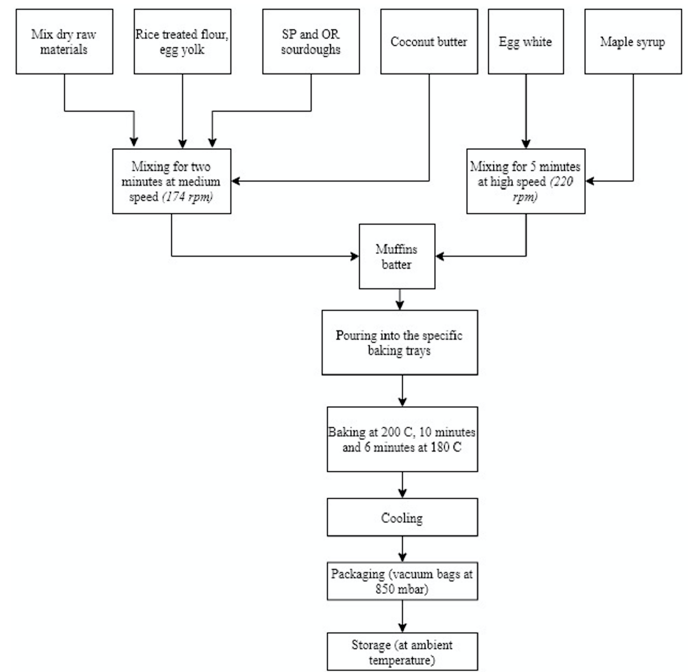
Figure 1. Flow diagram of muffin production.